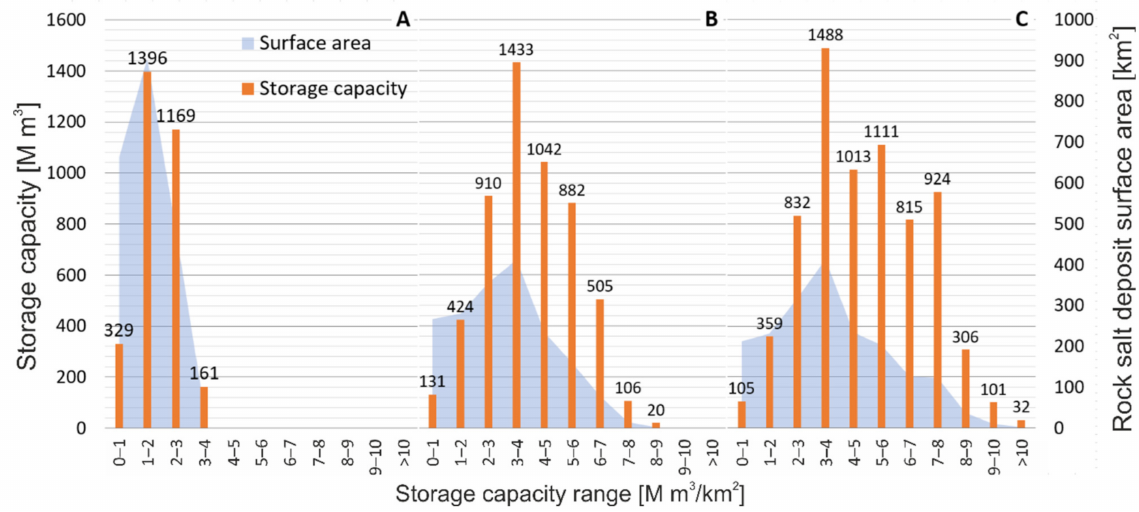
Figure 7. The analysis results of the unique raster values of liquid fuel storage capacity (( A ) initial state of operational storage, ( B ) target state of operational storage, ( C ) strategic